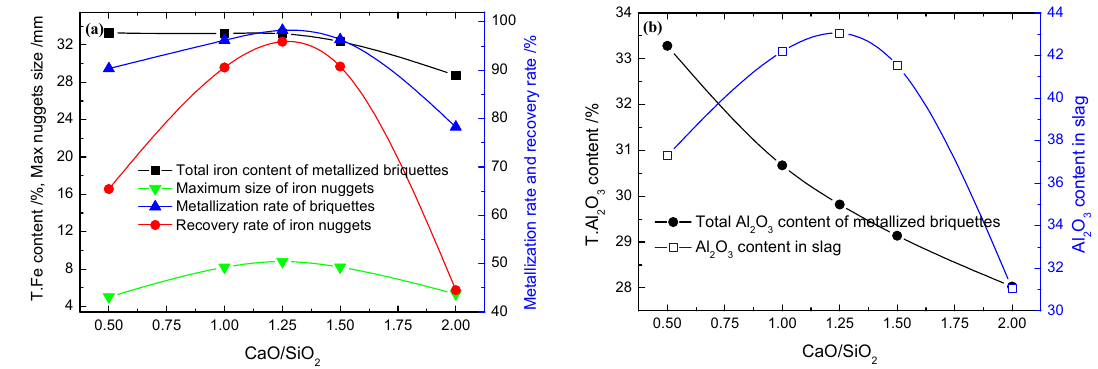
Figure 7. Effect of the ( a ) CaO/SiO 2 ratio on the reduction indexes and ( b ) Al 2 O 3 .